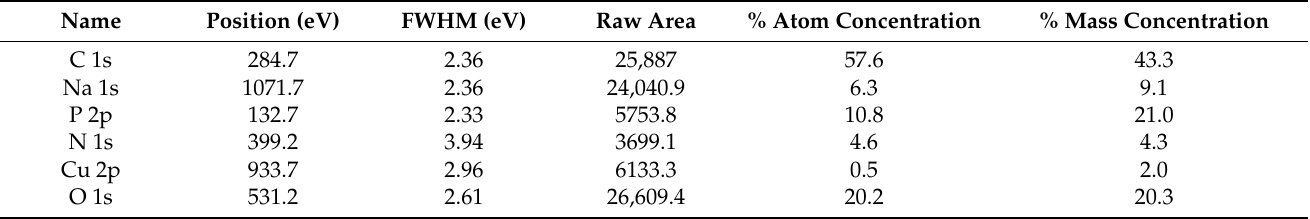
Table 9. The XPS analysis results obtained in the narrow range of binding energy for Purolite S 950 after sorption of Cu(II) ions.